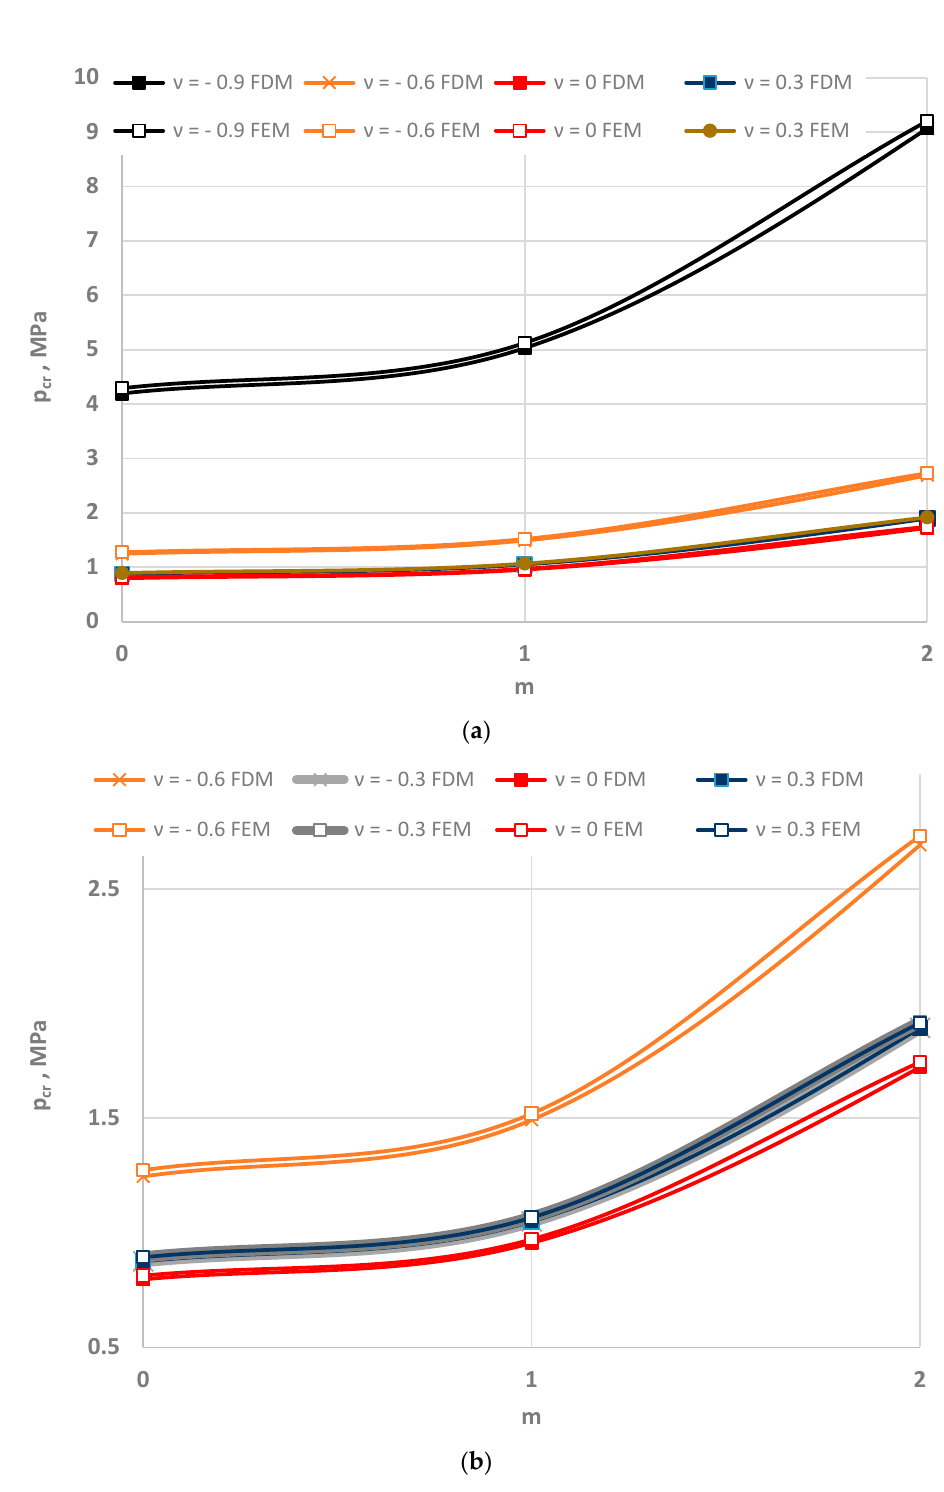
Figure 6. Critical static load p cr distribution versus mode m for the FDM and FEM homogeneous plate models radially compressed on the inner edge: for values of Poisson’s ratio ν = − 0.9, − 0.6 and ν = 0, 0.3 ( a ), for values of Poisson’s ratio − 0.6 ≤ ν ≤ 0.3 ( b ).